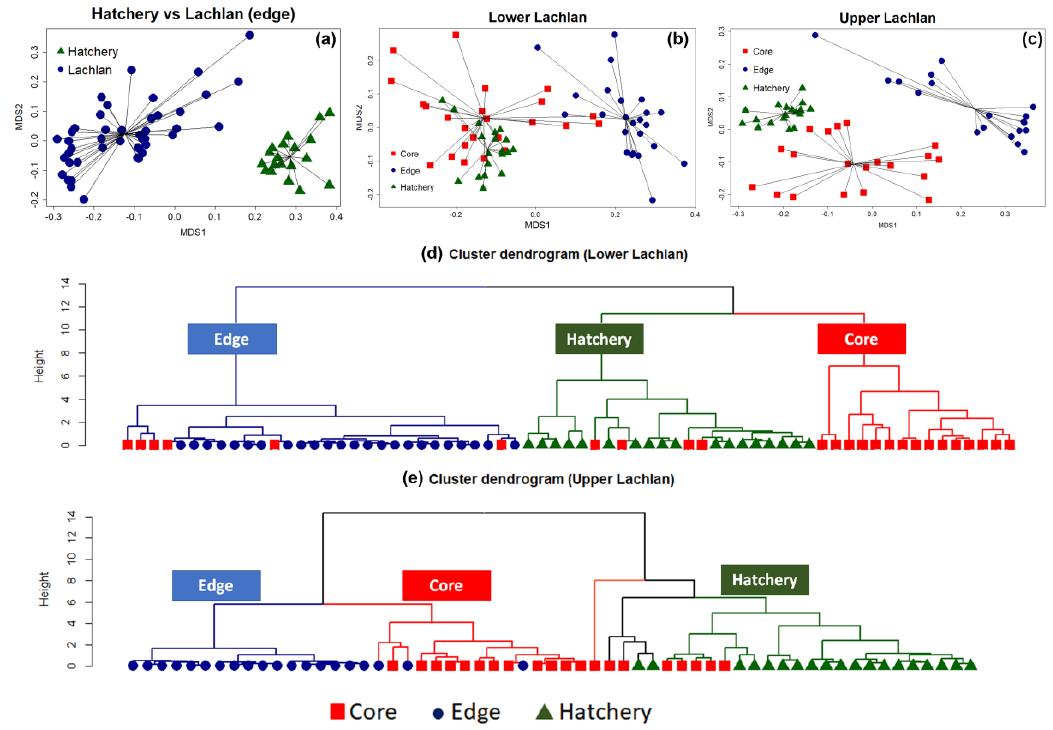
Figure 3. Non-metric multidimensional scaling (NMDS) and cluster analysis showing the presence of both wild-born and hatchery-bred stocked M. ambigua from the Lachlan River. ( a ) NMDS spider plot between the edge of the Lachlan river sample and the hatchery reference individuals (Hatchery YOY); ( b ) NMDS spider plot among the edge and core of the lower Lachlan river sample with the presence of the hatchery reference; ( c ) NMDS spider plot among the edge and core of the upper Lachlan river sample with the presence of the control group (Hatchery YOY); ( d ) Cluster dendrogram of the lower Lachlan samples and the hatchery reference based on a Euclidean distance matrix representing the presence of natural recruitment in the lower Lachlan catchment; ( e ) Cluster dendrogram of the upper Lachlan samples and hatchery reference group based on a Euclidean distance matrix representing no natural recruitment with two distinct clusters between the Lachlan River samples and hatchery reference group.